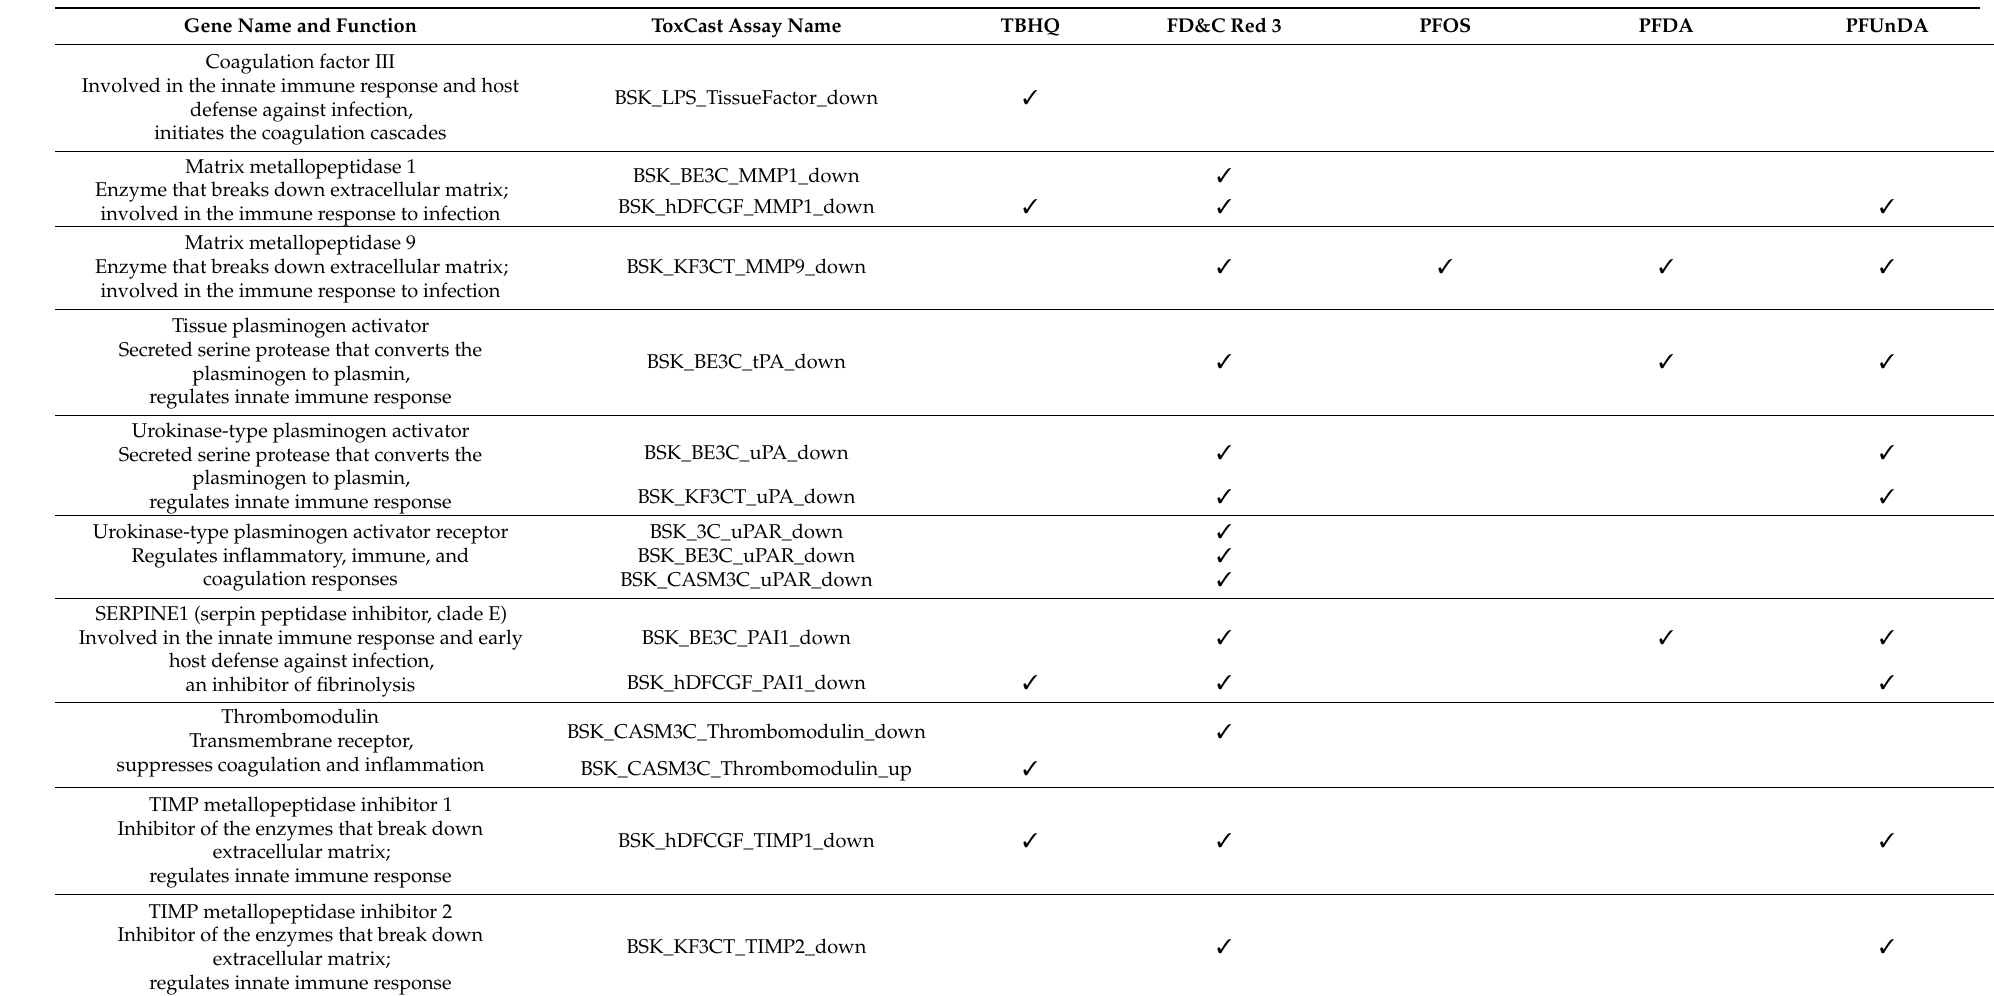
Table 4. ToxCast assays targeting extracellular matrix remodeling, coagulation, and